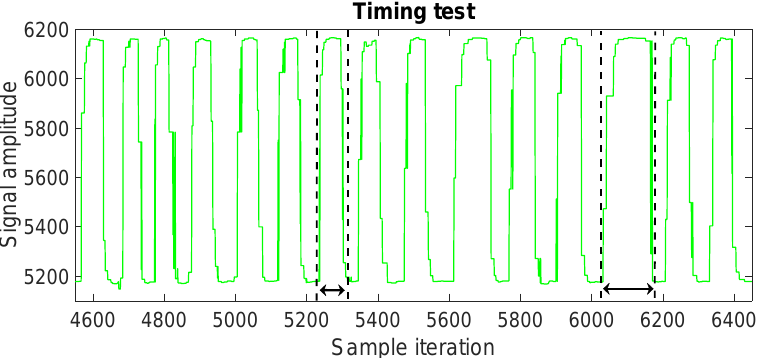
Figure 8. Illustration of variable timing drift experienced during sampling